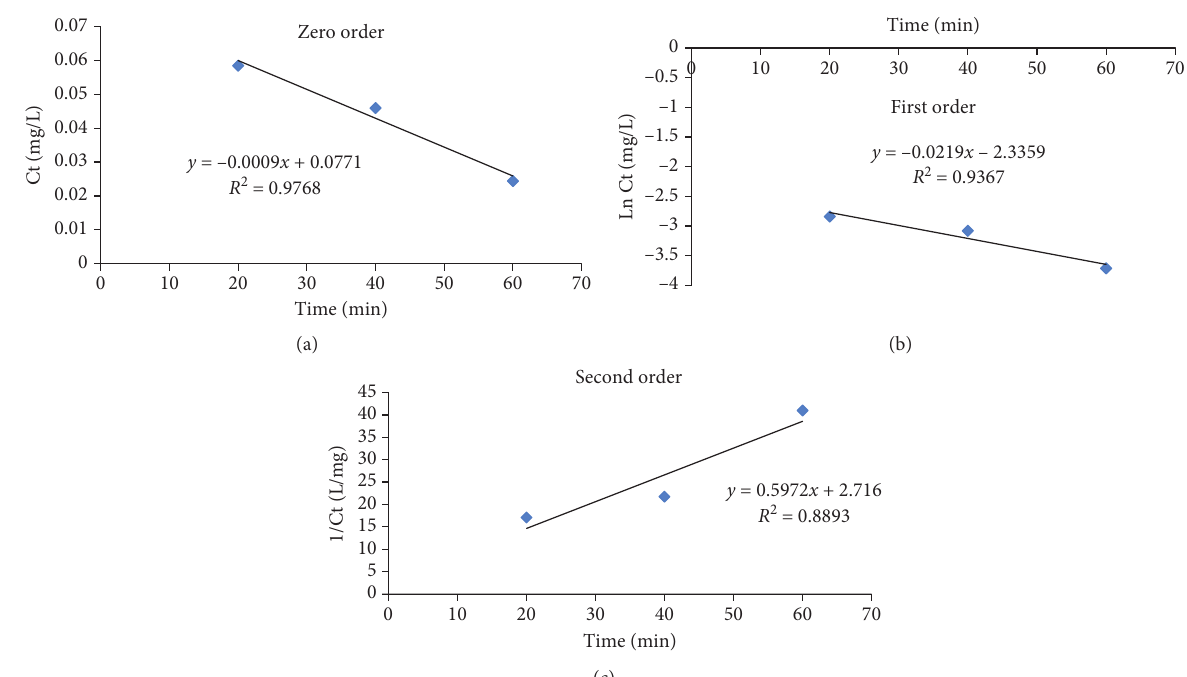
Figure 7: The rate of trifluralin removal reaction in the UV/S2O28 process (the initial concentration of trifluralin and S2O28 is 1.2mg/L and 40 µ M, respectively, pH � 9, UV � 6 W).